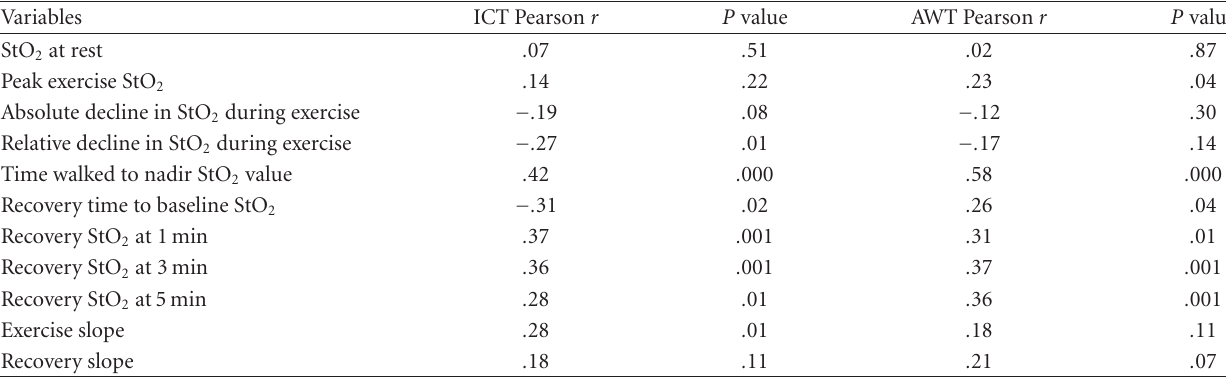
Table 2: Relationships between selected variables and initial claudication and absolute walking times ( n = 85).